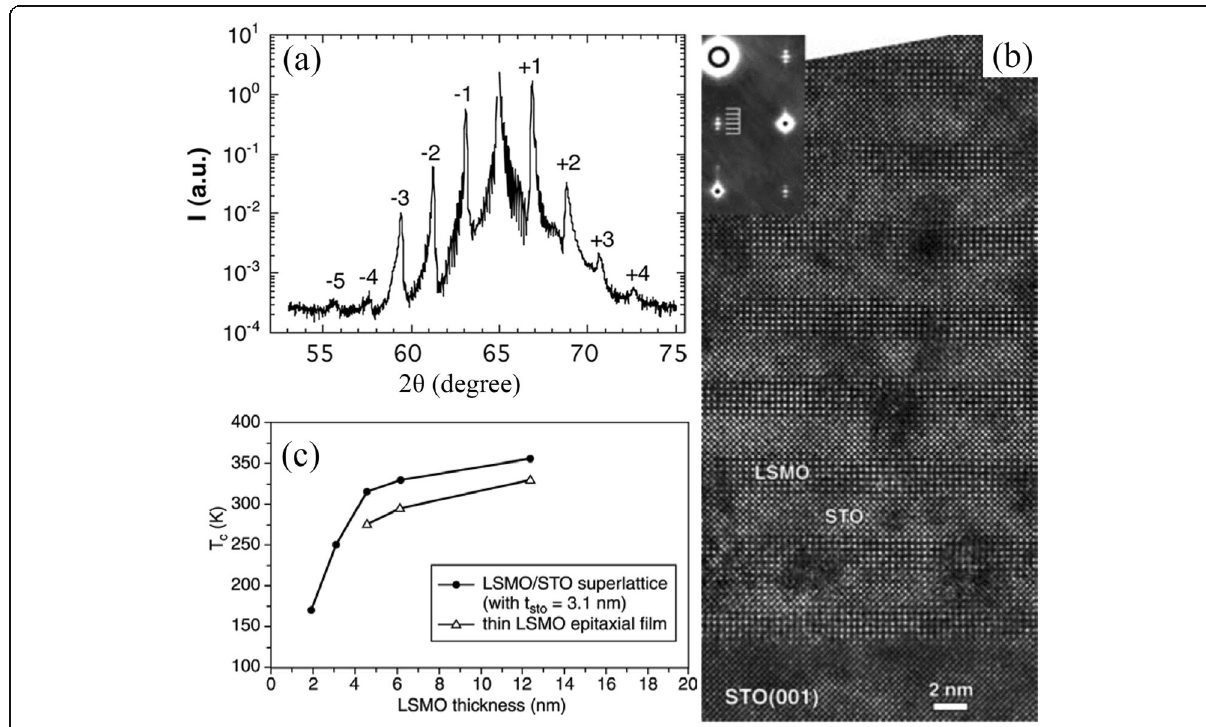
Fig. 12 a XRD pattern (synchrotron) of the [(La 0.7 Sr 0.3 MnO 3 ) 5 (SrTiO 3 ) 8 ] 15 superlattice. b Cross-sectional HRTEM image of the [(La